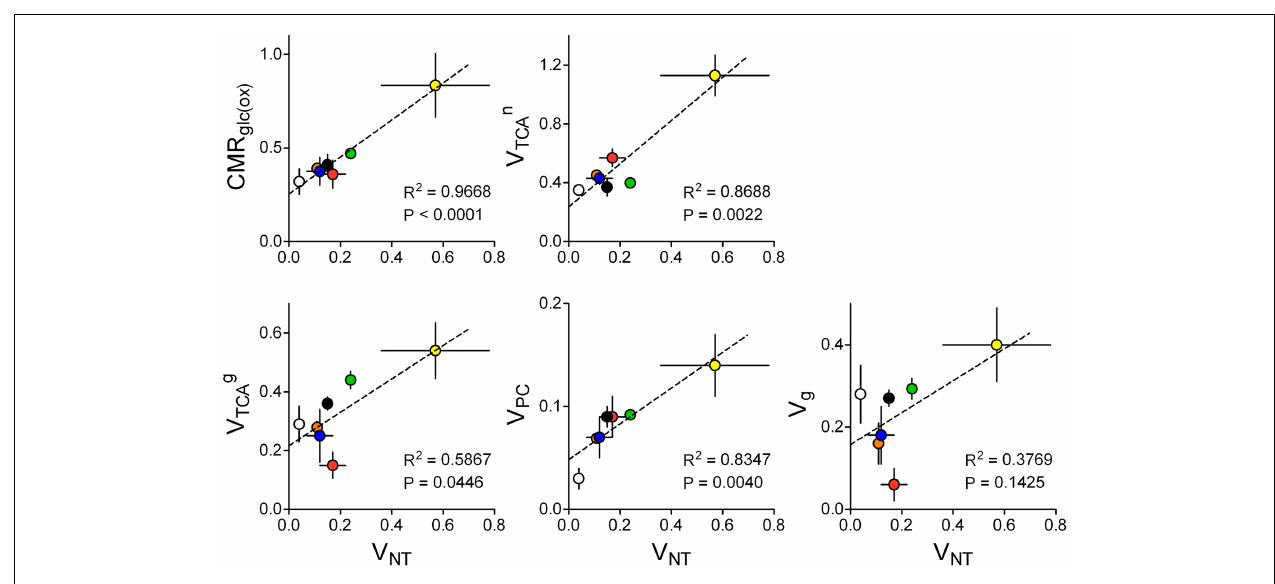
anesthesia [orange, blue, green, and black are data from Ref. (9, 10, 12, 35), respectively], human cortex [red; Ref. (29)], awake rat brain [yellow; Ref. (33)] . Metabolic fluxes are shown in micromoles per gram per minute with associated SD. P -value for the slope and R 2 are shown for each linear regression.